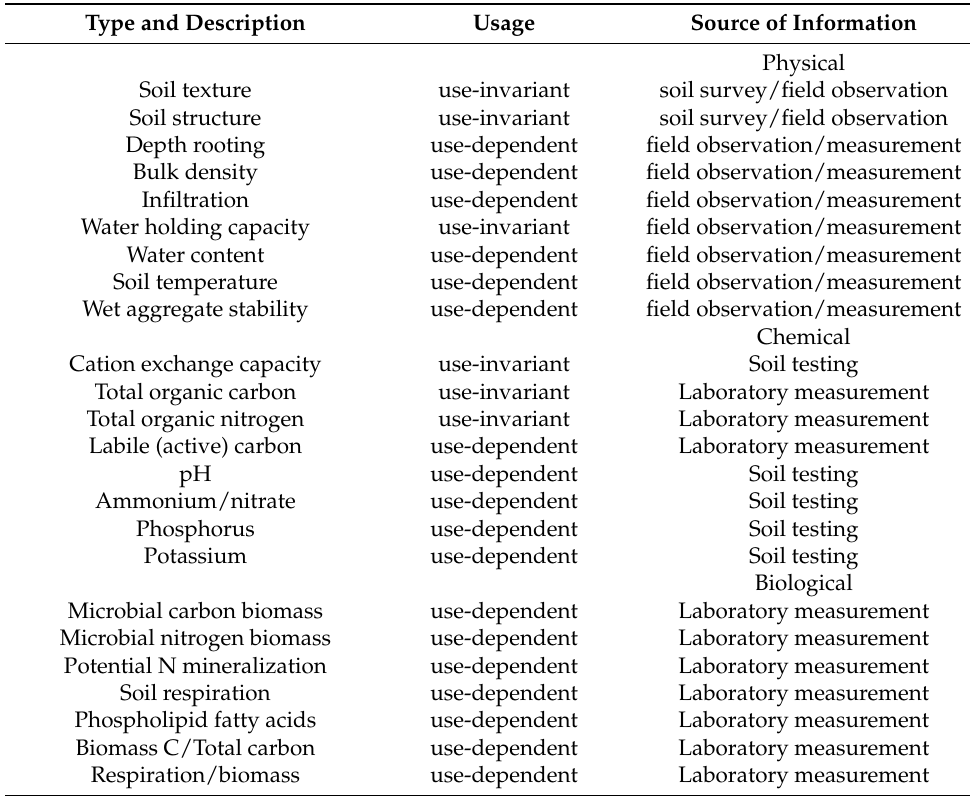
Table 1. Key soil indicators ranked as physical, chemical, and biological